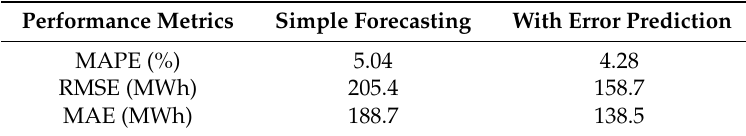
Table 1. Performance metrics for July